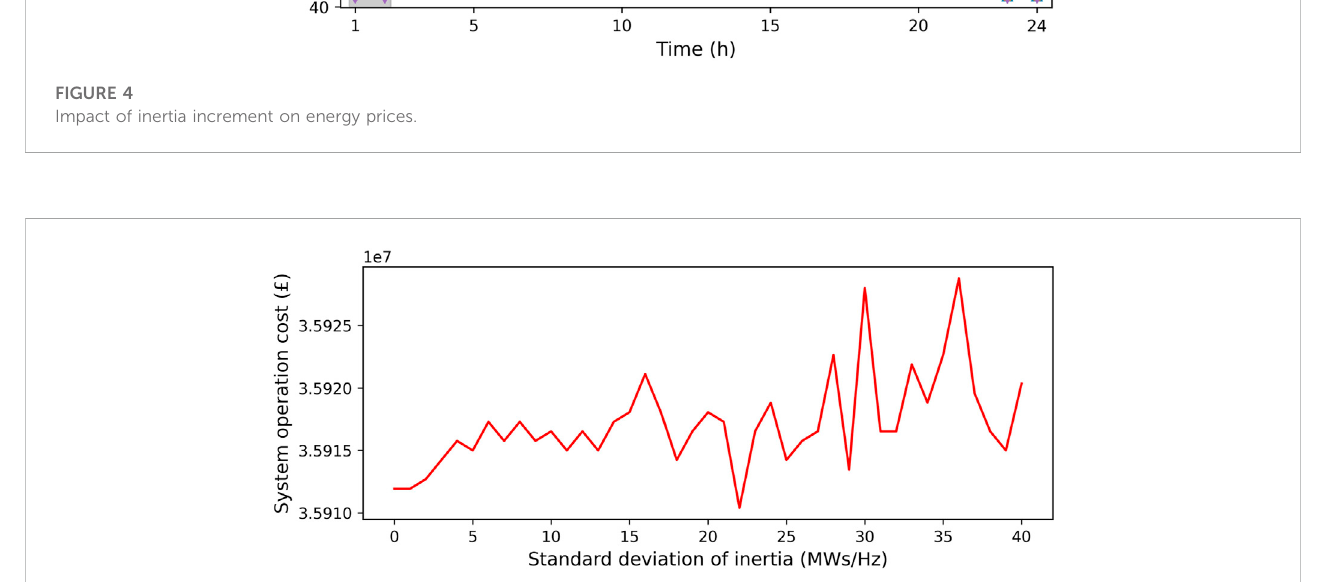
FIGURE 5 Impact of the standard deviation of inertia on system operation costs.